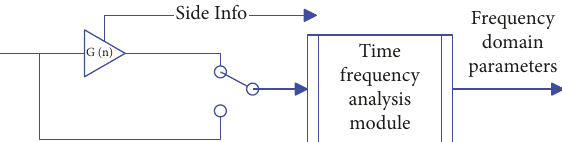
Figure 2: Reducing the nonstationarity of audio signals through gain